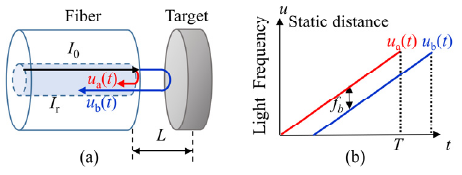
Figure 1. Model of the static distance. ( a ) The interference model of the static distance; ( b ) the light frequency change in a sweeping circle.